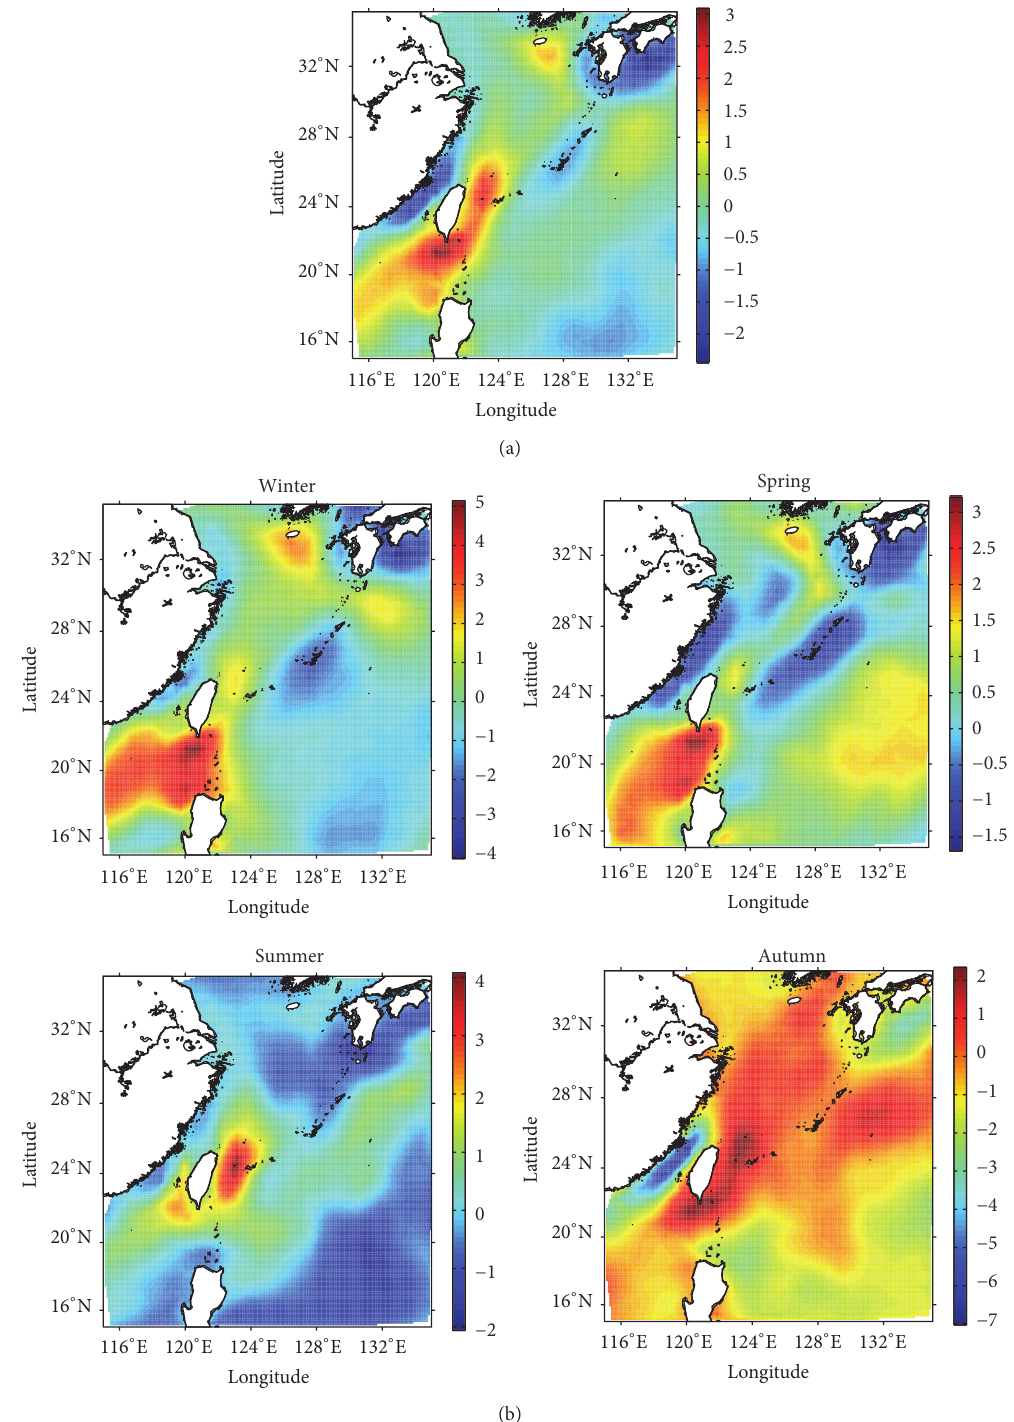
Figure 12: (a) Annual and (b) seasonal distribution of linear trends in wind power density for the period 1980–2009 in the ECS. Values on the side bars are in w/m 2 yr −1